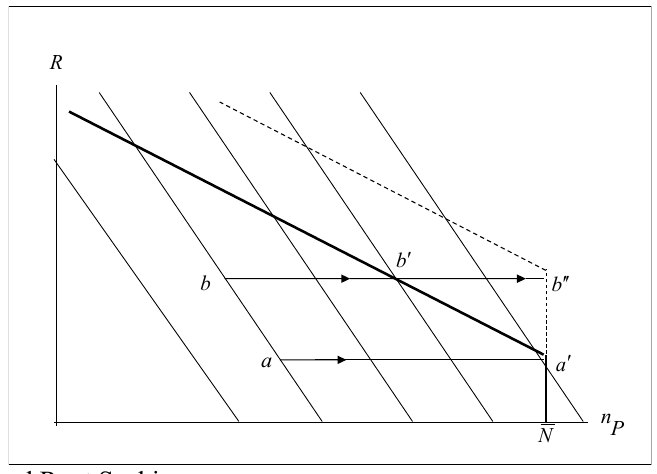
Figure 1. Resources and Rent